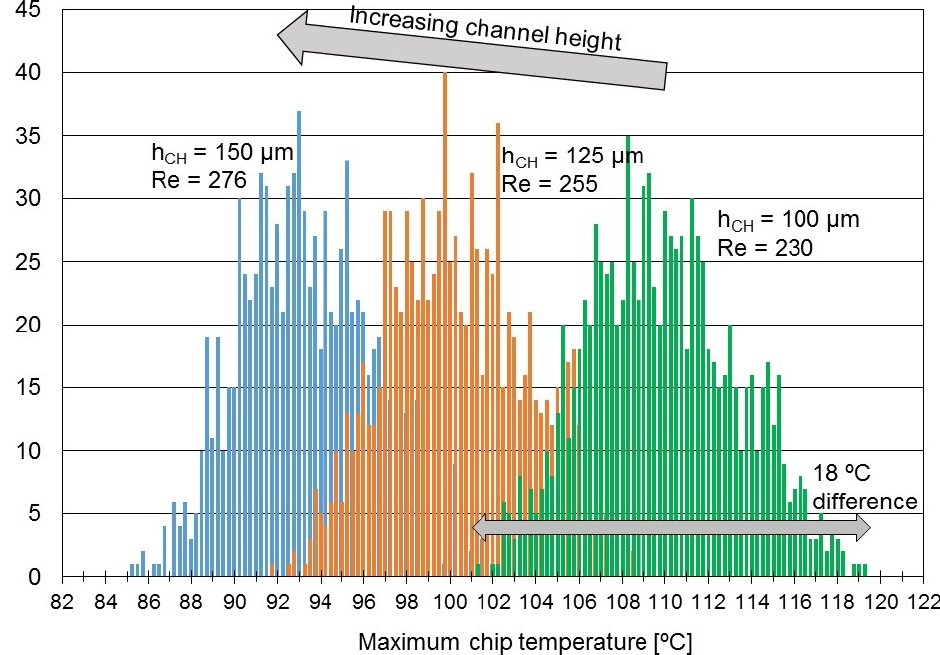
Figure 7. Peak temperature distribution (1000 cases in total) in the simulated 3D processor for various channel heights. Power consumption in processor cores was generated randomly once, and only power-to-core mapping was varied between cases. Re indicates the Reynolds number.